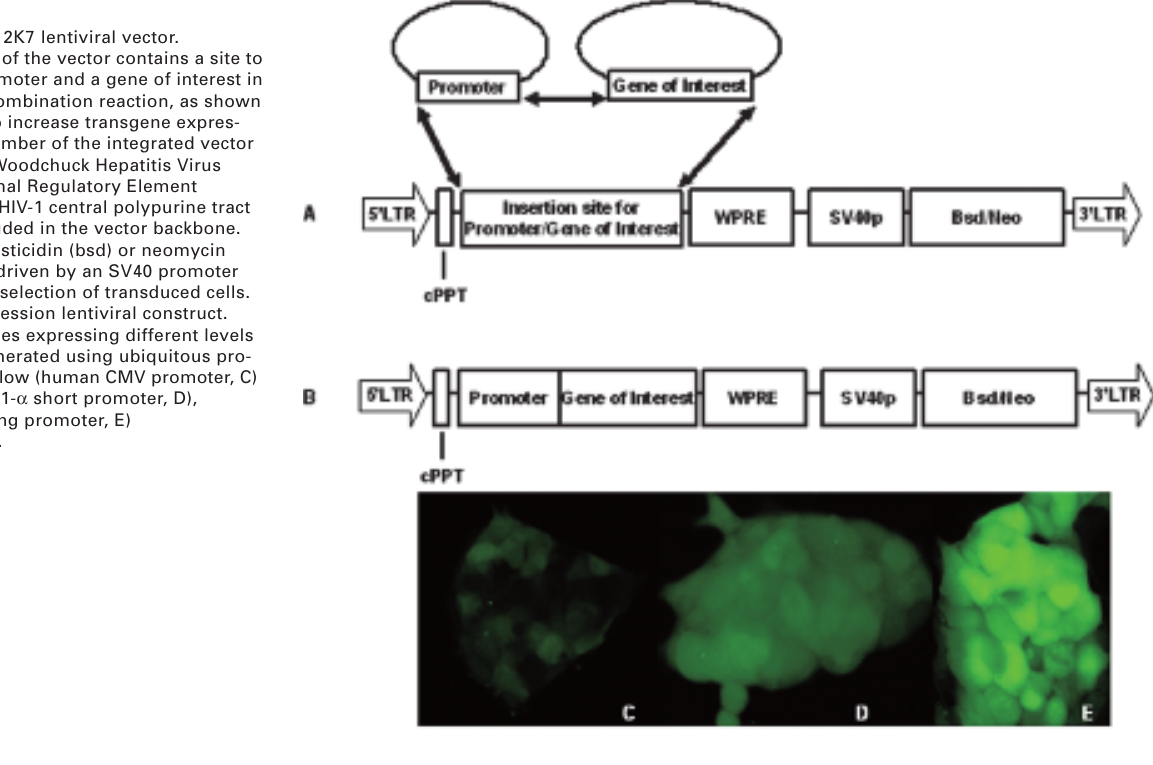
Schematic of the 2K7 lentiviral vector. A: The backbone of the vector contains a site to insert both a promoter and a gene of interest in a single-step recombination reaction, as shown by the arrows. To increase transgene expres- sion and copy number of the integrated vector in the host cell, Woodchuck Hepatitis Virus Post-transcriptional Regulatory Element (WPRE), and the HIV-1 central polypurine tract (cPPT) were included in the vector backbone. Finally, either blasticidin (bsd) or neomycin (neo) resistance driven by an SV40 promoter allows antibiotic selection of transduced cells. B: Resulting expression lentiviral construct. Mouse ES cell lines expressing different levels of eGFP were generated using ubiquitous pro- moters to obtain low (human CMV promoter, C) intermediate, (EF1- a short promoter, D), or high (EF1- a long promoter, E) eGFP